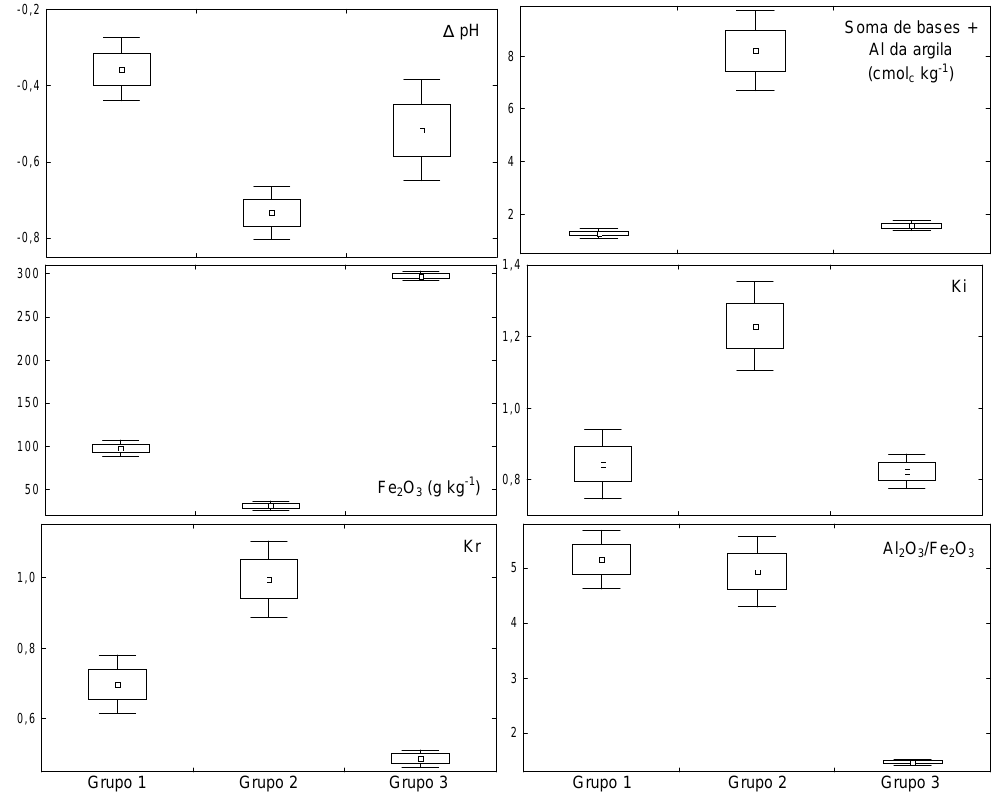
Figura 7. Médias, erro-padrão (box) e intervalo de confiança (barra de erro-padrão ××××× 1,96) de variáveis químicas de amostras de horizontes subsuperficiais dos grupos de perfis de solo: 1 = solos de textura argilosa a muito argilosa, hipo a mesoférricos; 2 = solos de textura média a arenosa, hipoférricos; 3 = solos de textura argilosa a muito argilosa,